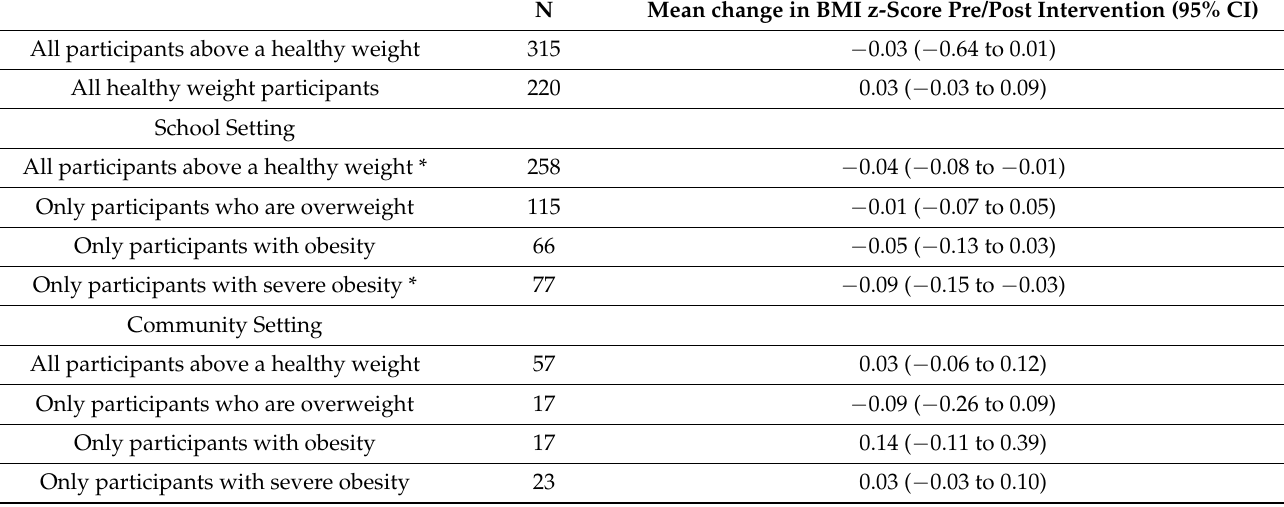
Table 4. Change in BMI z-score pre and post-intervention by setting and baseline BMI z-score. N Mean change in BMI z-Score Pre/Post Intervention (95%